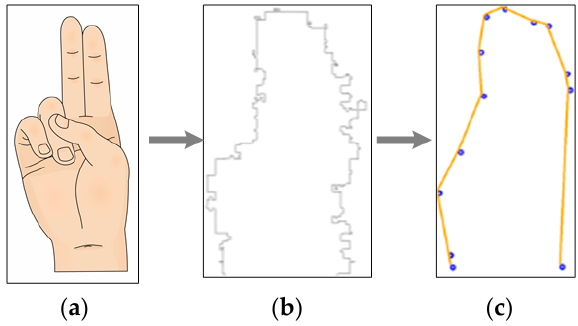
Figure 9. Shape reduction result using the vertical slope algorithm, ( a ) American Sign Language alphabet sign; ( b ) output image of edge tracing algorithm; ( c ) data representation after vertical slope